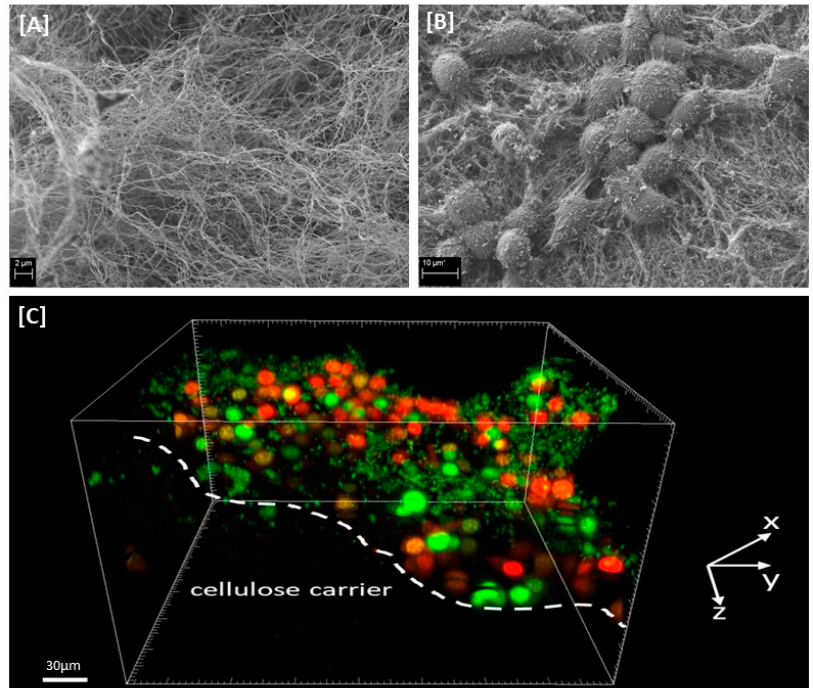
Figure 2. Presentation of cellulose-based biofilm model. ( A ) native cellulose-carrier (SEM, magn. 5000 × ); ( B ) cellulose carrier covered with fibroblasts (SEM, magn. 2500 × ); ( C ) staphylococcal (PRT9) biofilm formed on fibroblast-containing cellulose carrier visualized with confocal microscopy. Big red (dead) and green (live) oval shapes—fibroblasts; smaller green dots—staphylococcal cells. The figure shows a side view projection of the cellulose carrier (not visible) covered with a fibroblast layer and bacteria. A high share of dead fibroblasts (red oval shapes) during 24 h of co-culture with staphylococci is worth noting.